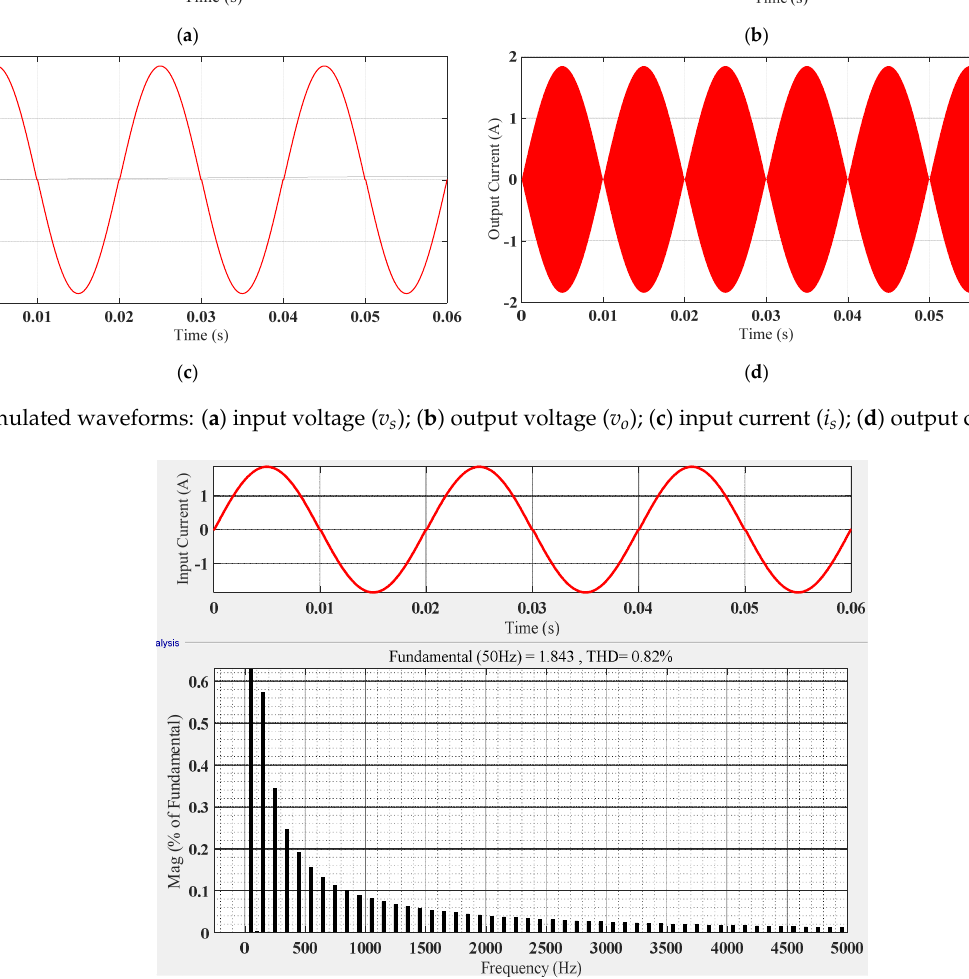
Figure 8. Validation for power quality of the input current.